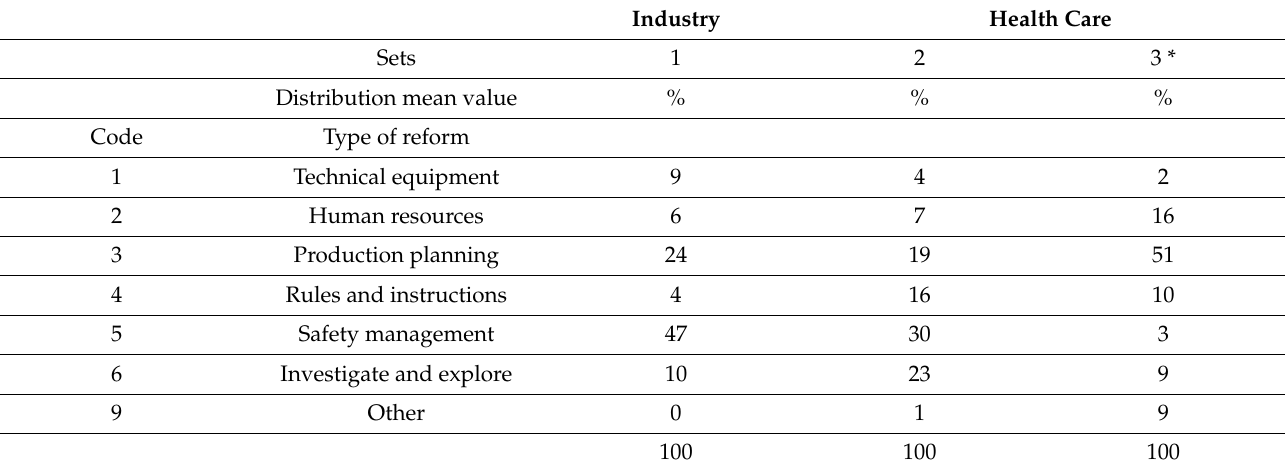
Table 9. Types of suggested reforms from three sets of investigations with mean values of distributions.